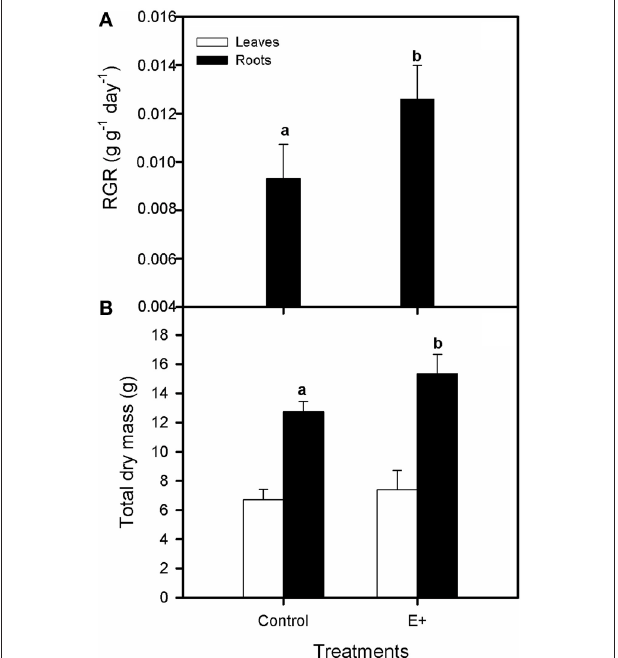
FIGURE 4 | Effect of inoculation (control, without inoculation; E + , inoculations repeated once a week during experimental period) with a bacterial consortium integrated by Micrococcus yunnanensis SMJ12, Vibrio sagamiensis SMJ18 and Salinicola peritrichatus SMJ30 on relative growth rate, RGR (A) and aboveground biomass and belowground biomass (B) in Spartina maritima plants grown in natural soil from Tinto marsh for 30 days. Values are means ± s.e. ( n = 10 ). Statistical differences between means are indicated by different letters ( P < 0.05